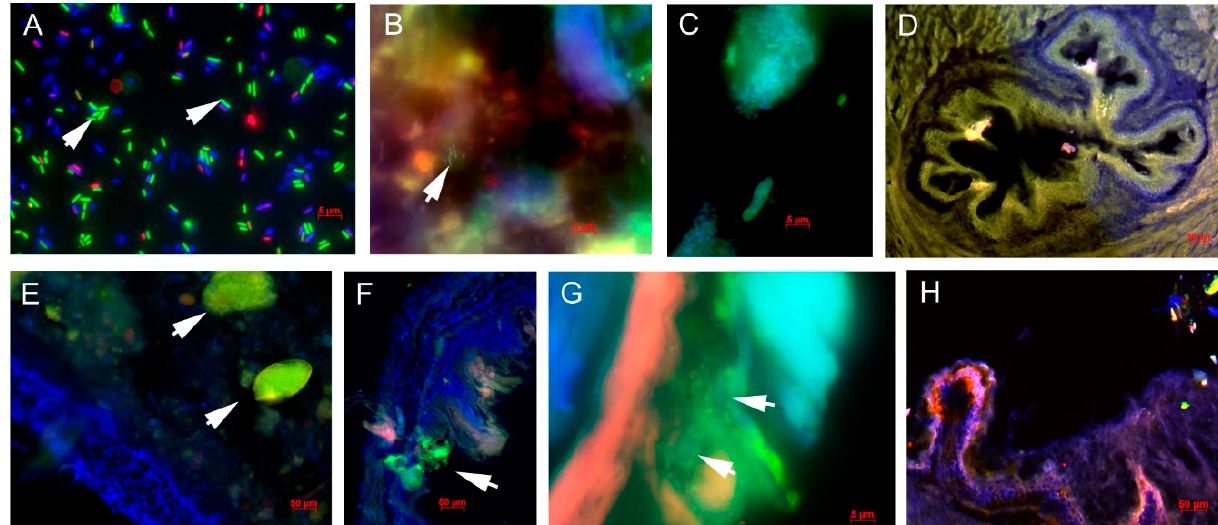
Figure 9. Results of Histo-FISH analysis. ( A )—Viability fluorescent quick test on polycarbonate filter (VFQTOPF) showing viability of microorganisms in the inoculum containing Lacticaseibacillus paracasei Ž2; arrows indicate live bacteria (cFDA) depicted in green, whereas dead cells (PI) are depicted in red, and blue represents the DNA of cells stained with DAPI. For the detection of Lactobacillus spp. a Lab158 prove was used, labeled with 6-FAM emitting green fluorescence. DNA of cells was stained with DAPI, emitting blue fluorescence ( B – H ). ( B )—Detection of Lactobacillus spp. (arrow) in the stomach content of the LP group. ( C )—Kefir grain with Lactobacillus spp. bacteria (green) in the stomach content of the KEF group. ( D )—Histological section of the gastric cardia with minimal biofilm formation (LP group). ( E , F )—Particles composed of mostly Lactobacillus spp. (arrows) detected close to the forestomach surface in the KEF group. ( G )—Biofilm formed by Lactobacillus spp. on the mucin layer on the forestomach surface in the LP group. ( H )—No occurrence of Lactobacillus spp. on the forestomach surface of control mice.